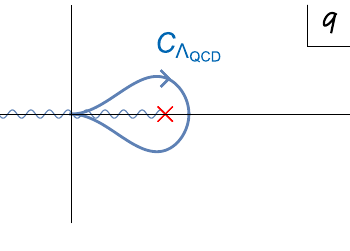
Figure 14 . Contour C (cid:3)